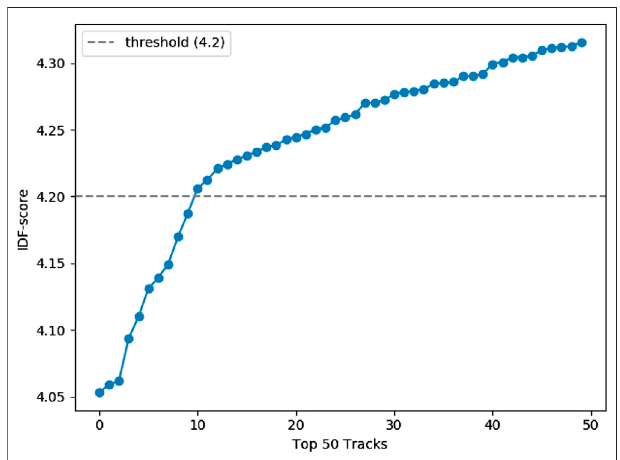
FIGURE 6 | Inverse document frequency (IDF) scores for the top 50